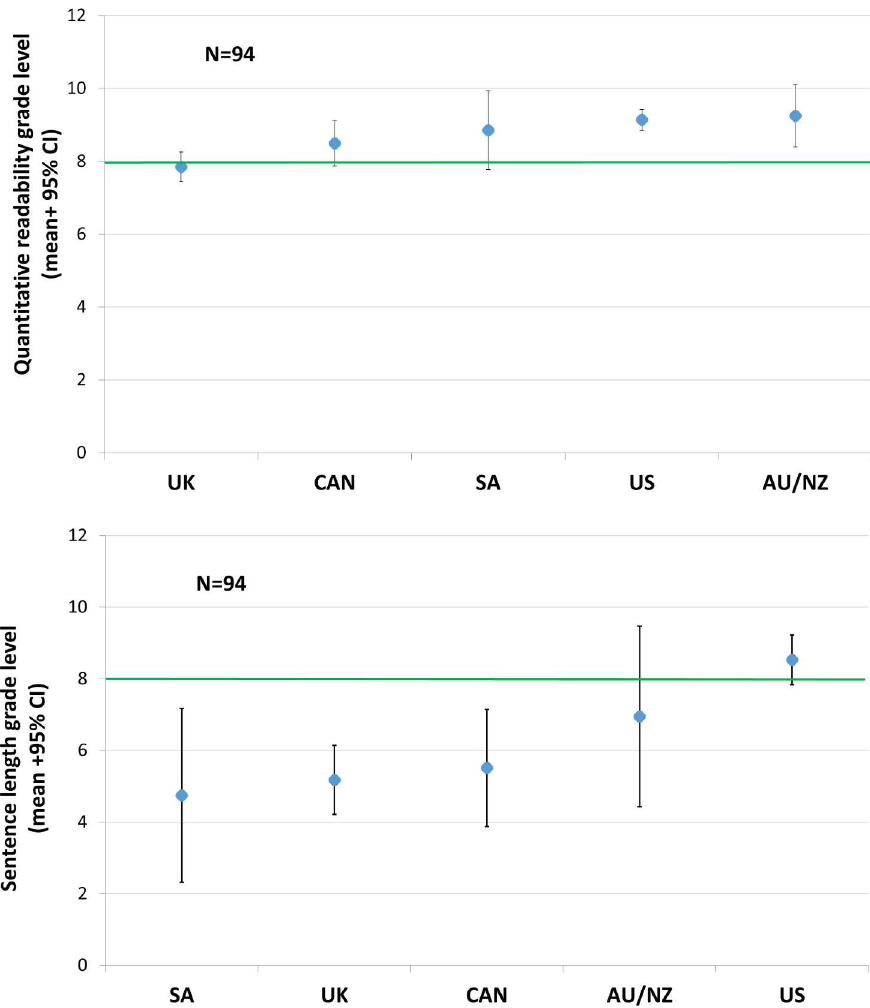
Fig 3. Grade levels for quantitative readability and sentence length, stratified by country of